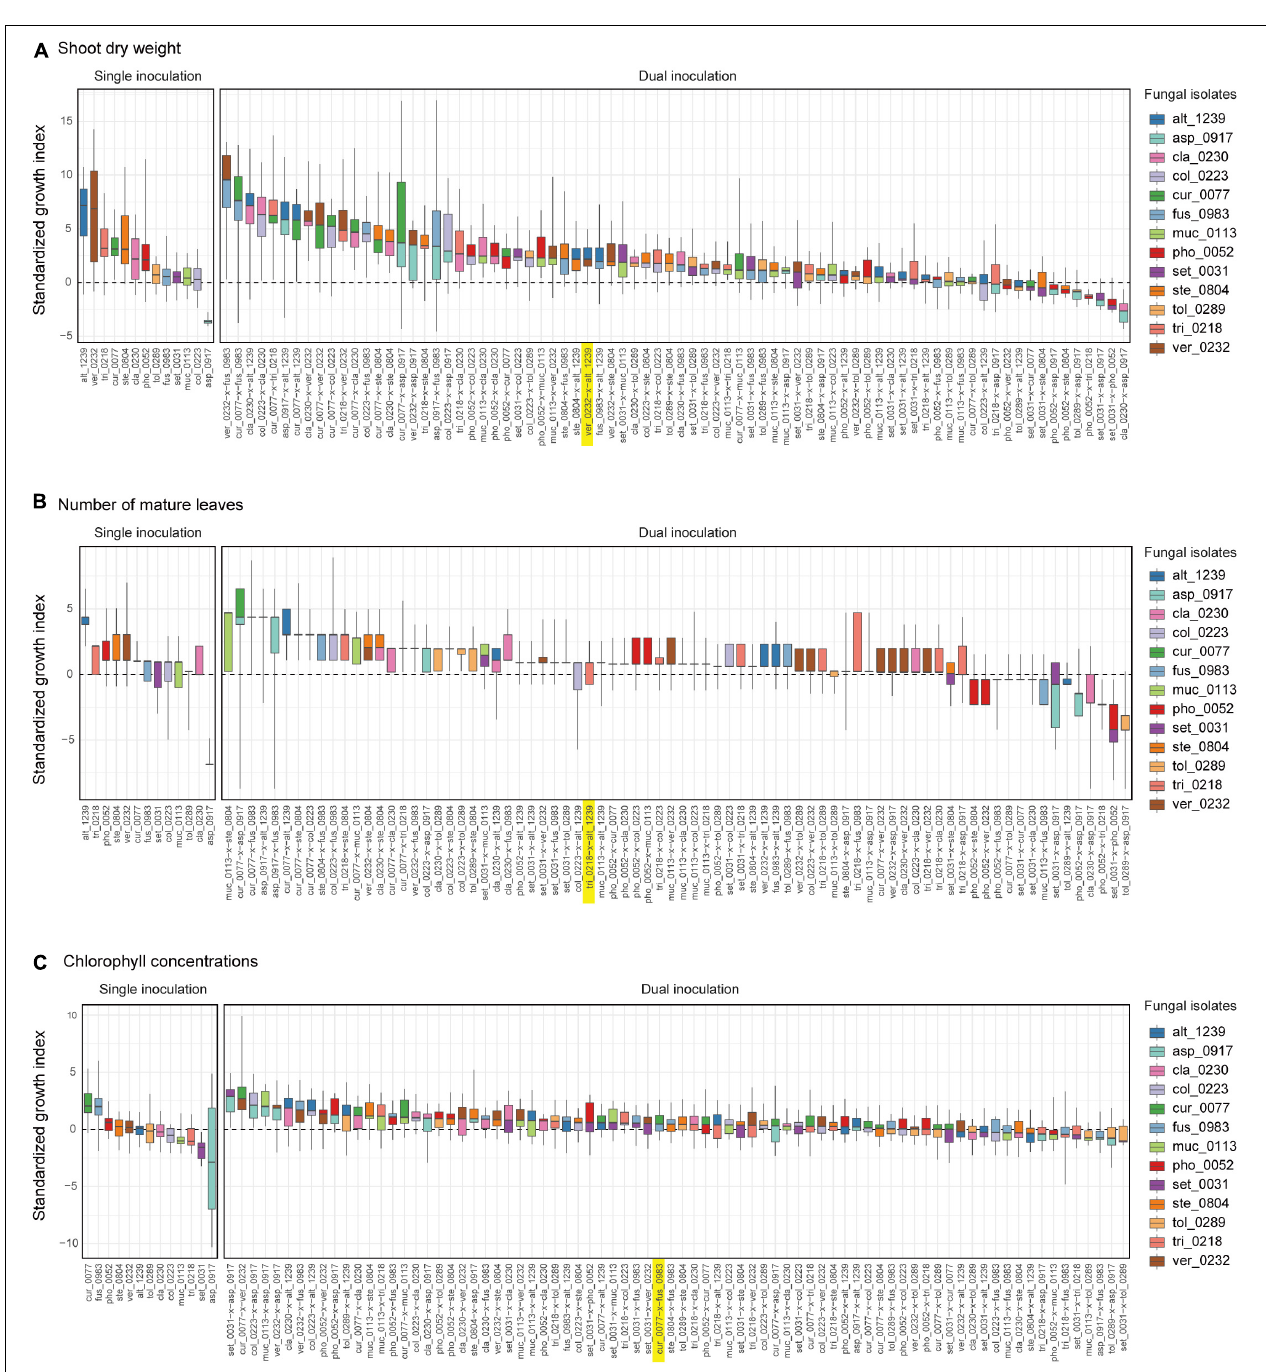
FIGURE 2 | Single- and dual-inoculation effects on Brassica plants. (A) Standardized growth index in terms of shoot dry weight. For respective single- and dual-inoculation experiments, 25% quantiles, medians, and 75% quantiles are displayed as boxes and the ranges from the maximum to minimum values are shown as bars. See Table 1 for the abbreviation of fungal isolates. The combination of the fungal species with the largest positive effects on Brassica plants in single inoculation experiments is highlighted. (B) Standardized growth index in terms of the number of mature leaves. (C) Standardized growth index in terms of chlorophyll